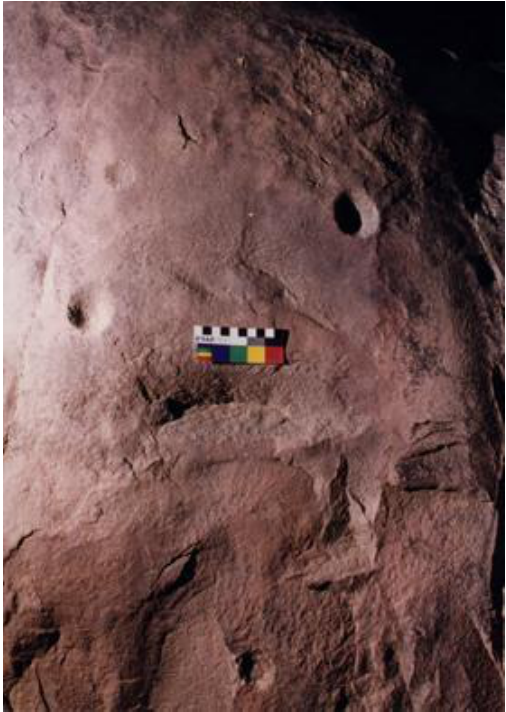
Figure 20. Four of the nine cupules occurring above ground in Auditorium Cave, but also thought to be of the Lower